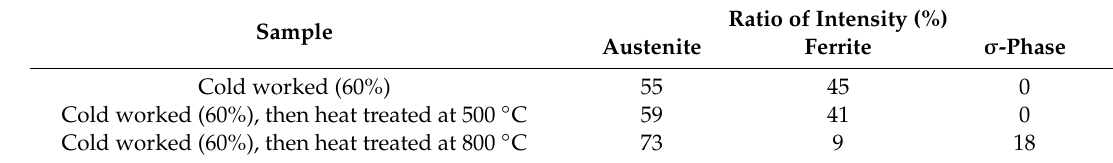
Table 2. Approximate proportion of phases in the samples determined by X-ray di ff raction (XRD). Ratio of Intensity (%) Sample Austenite Ferrite σ -Phase Cold worked (60%) 55 45 0 Cold worked (60%), then heat treated at 500 ◦ C 59 41 0 Cold worked (60%), then heat treated at 800 ◦ C 73 9